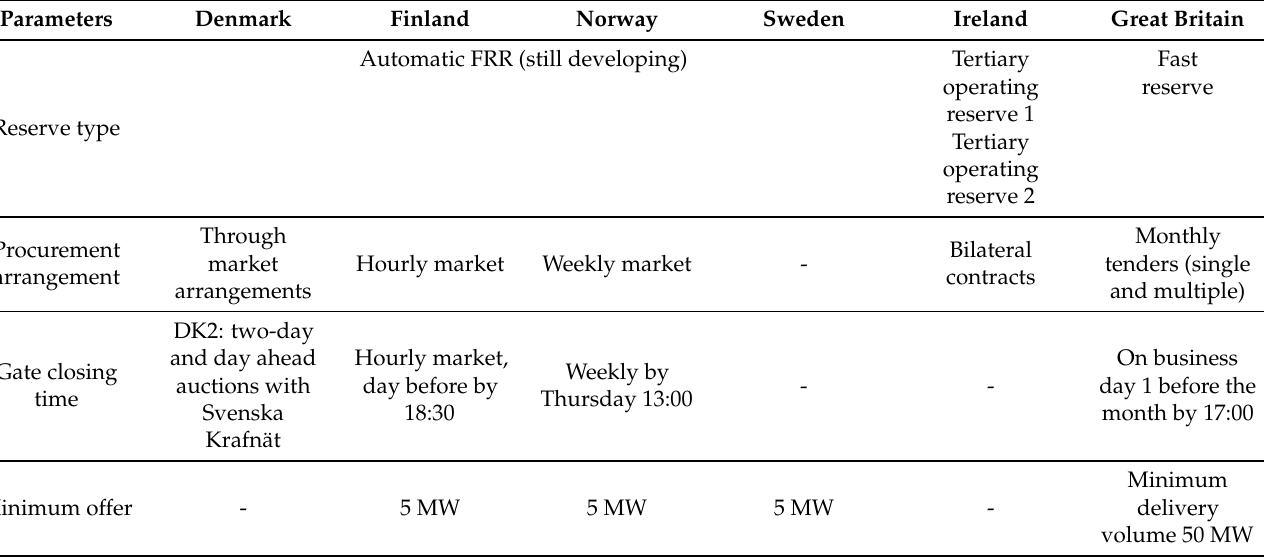
Table 3. Summary of FRR-A services unified under the ENTSO-E classification, including Nordic countries, Ireland and Great Britain.